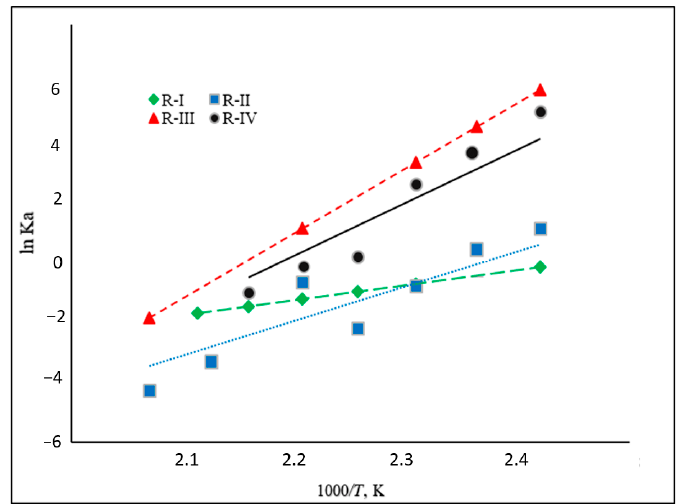
Figure 4. Relationships between equilibrium constant and temperature for reactions R-I to R-IV (see Figure 2).